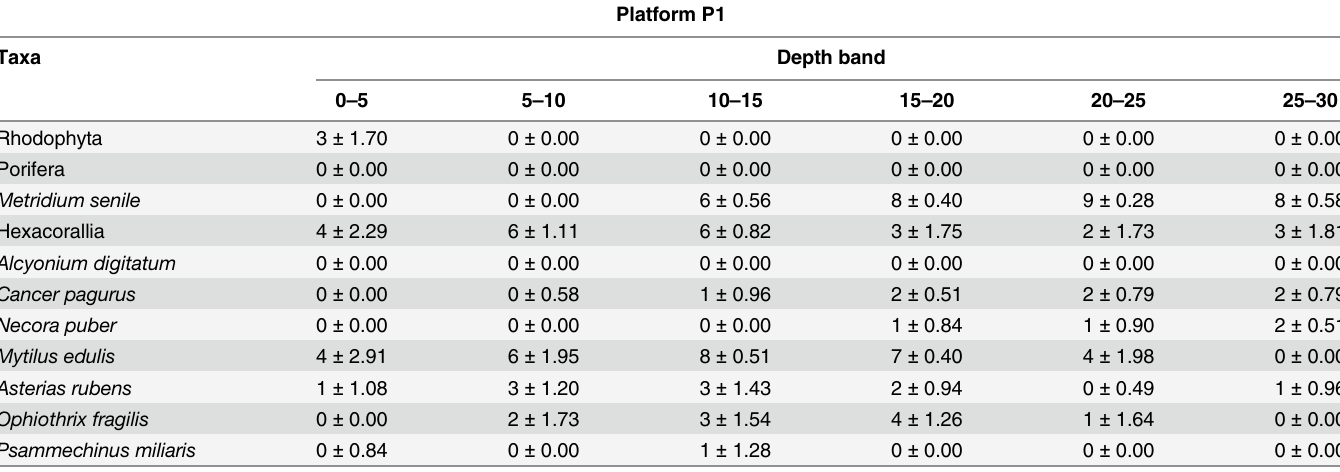
Table 4. Averaged categorised abundance of the 11 high detectable taxa, with 95% confidence interval around the mean, per depth band on plat- form P1.